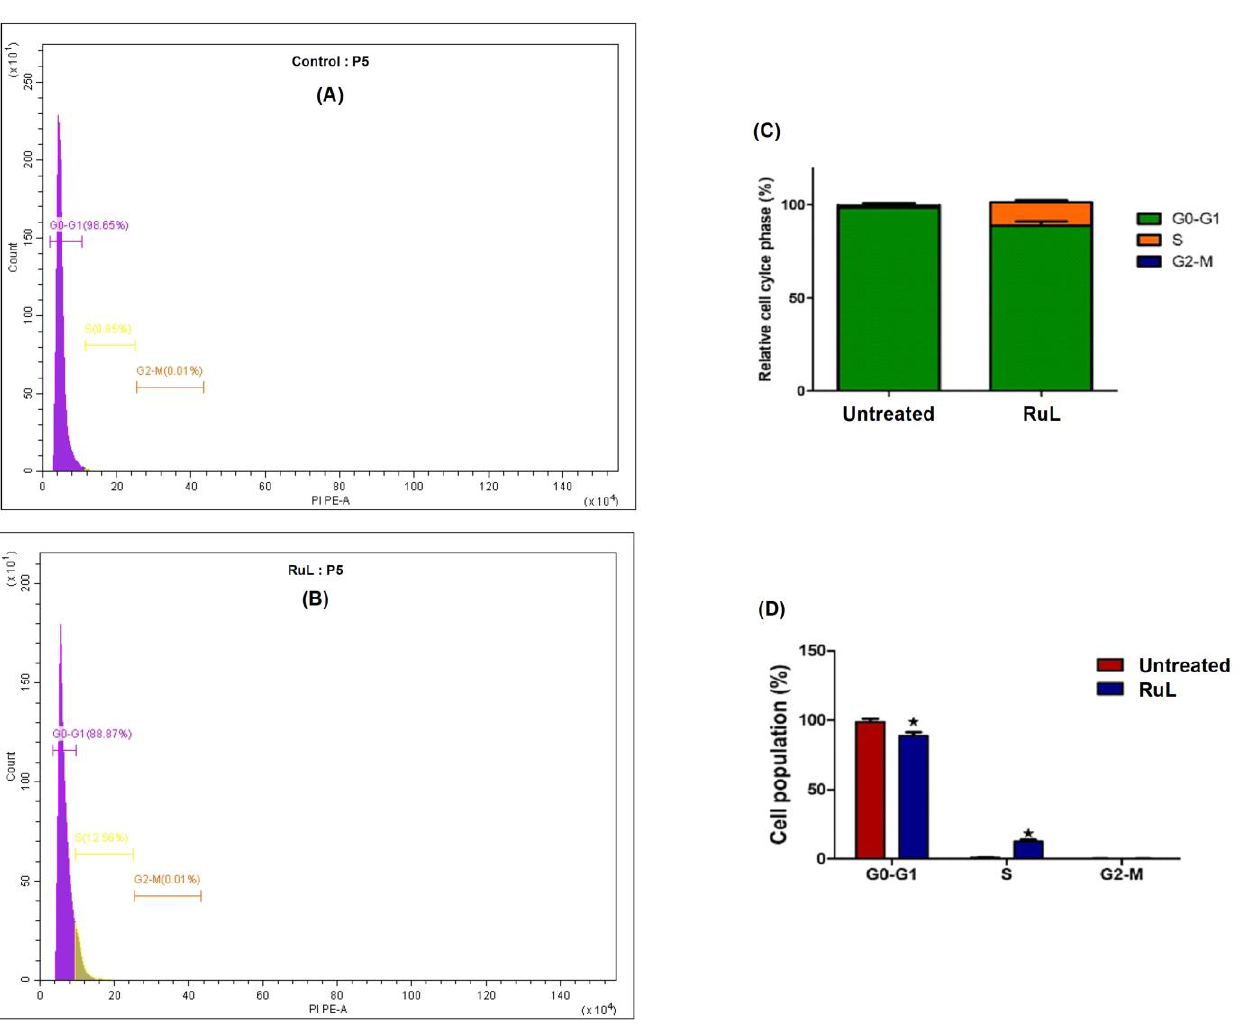
Figure 4. Cell cycle distribution upon treatment with RuL on HepG2 cells: ( A ) the untreated control, ( B ) the treatment of cells by RuL , ( C ) the effect of RuL on the cell cycle distribution of HepG2 cells, ( D ) cell population against cell cycle phases. Data are expressed as mean ± SD performed in triplicate. Statistical differences were analyzed with a t-test. * Significant at p < 0.05.